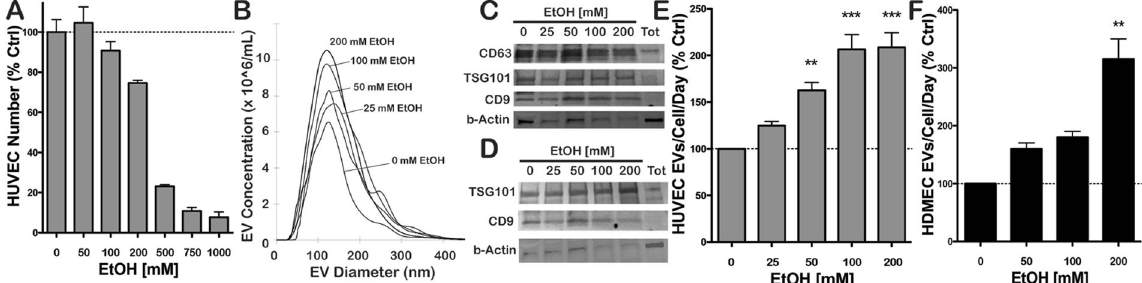
Figure 1. Endothelial cell production of EVs in the presence of alcohol. ( A ) HUVEC survival was assessed with the indicated concentrations of ethanol (EtOH) included in growth medium (EGM2) (n = 3). ( B ) HUVEC EV size distribution in the presence or absence of the indicated concentrations of EtOH in the medium was assessed via NanoTracking Analysis (NTA) using a NanoSight LM10 (n = 3). Immunoblots for proteins associated with exosomes were performed for ( C ) HUVEC EVs and ( D ) HDMEC EVs isolated from producer cells cultured with the indicated EtOH concentrations. Blots shown are representative of three independent experiments. EV production rate by cells in medium containing the indicated EtOH concentrations was determined by NTA for ( E ) HUVEC and ( F ) HDMEC; n = 3, ** P < 0.01, *** P < 0.001 compared to 0 mM EtOH